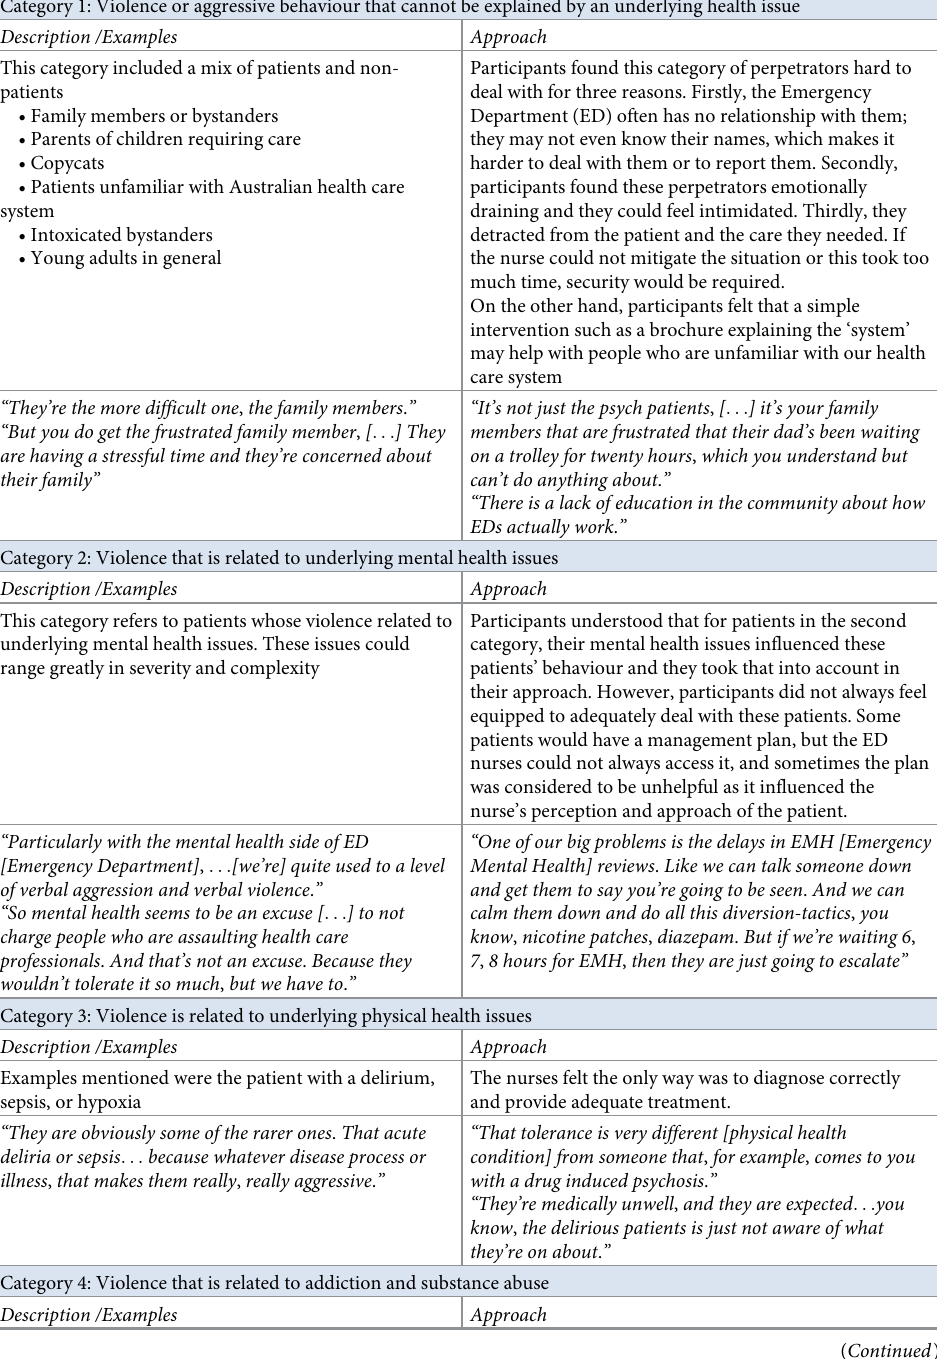
Table 2. Overview of six categories of